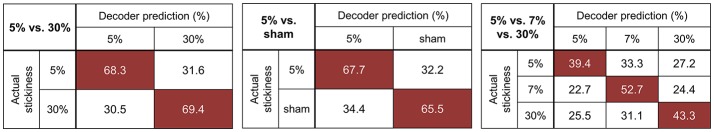
Confusion matrices for the identified clusters of each searchlight analysis. The rows of the matrix indicate the actual stickiness provided to the participants (true label) and the columns indicate the predictions by a classifier (predicted label). The cells of highest accuracy in each row are highlighted in red. The chance levels for the 5 vs. 30 and 5% vs. sham stimuli classification are 50%. As for the 5 vs. 7 vs. 30% stimuli classification, the chancel level is 33.3%.